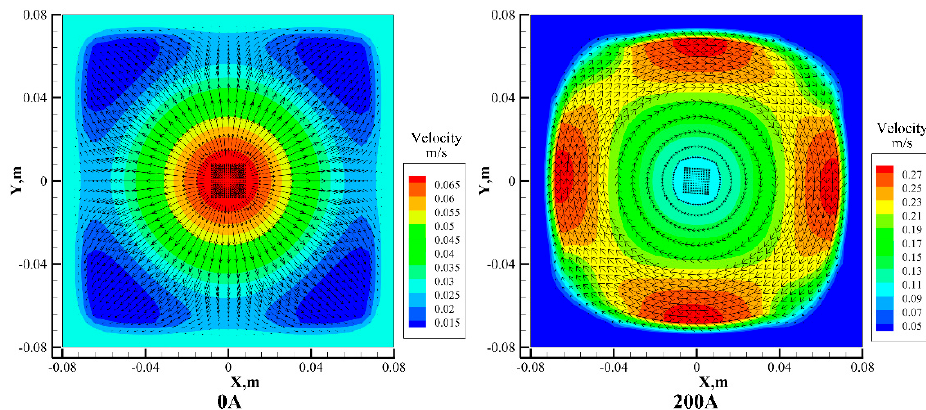
Figure 5. The contour and vector of flow field on the cross section at the center of M-EMS: ( a ) without M-EMS ( I = 0 A), ( b ) with M-EMS ( I = 200 A).